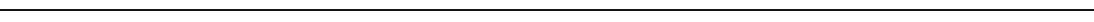
(See figure on previous page.) Fig. 6 Hovmöller zonal – time diagrams for the zonal component of energy flux (color shaded in units of W/m 2 ) at a , b sea surface, c , d 550 m depth, and e , f 1100 m depth. Left panels show the equatorial behavior, while right panels are for 3° N. Energy flux has been estimated using the depth-dependent version of the Aiki, Greatbatch, and Claus Level-2 scheme, as given by (7b). Panels ( a , b ) include wind-forced wave energy input (solid contours for positive values, dotted contours for negative values; contour interval = 0.002 W/m 2 ) following (12). All quantities are from “ Year 20 ” of the model experiments associated with first six fundamental baroclinic modes. In the left-hand panels, theoretical phase speeds calculated for both Kelvin waves and equatorial long Rossby waves are shown as solid blue lines